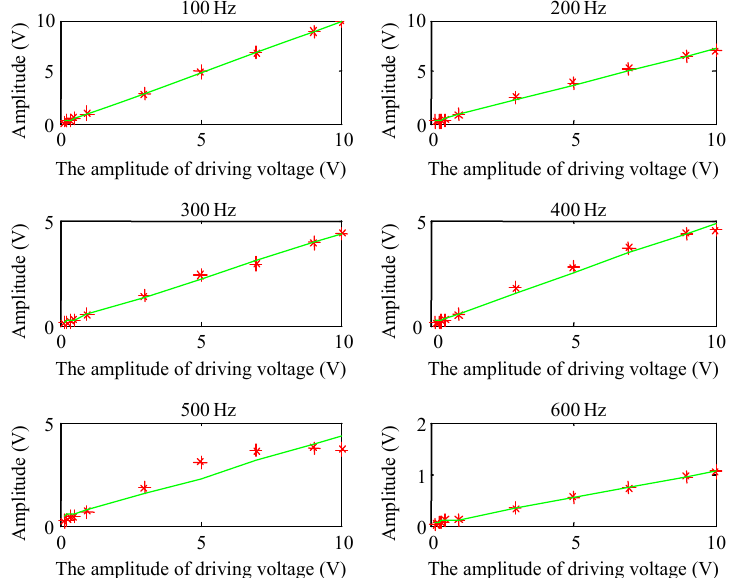
Fig. 9. Relationship between the amplitudes of the driving voltage and demodulated signal at different